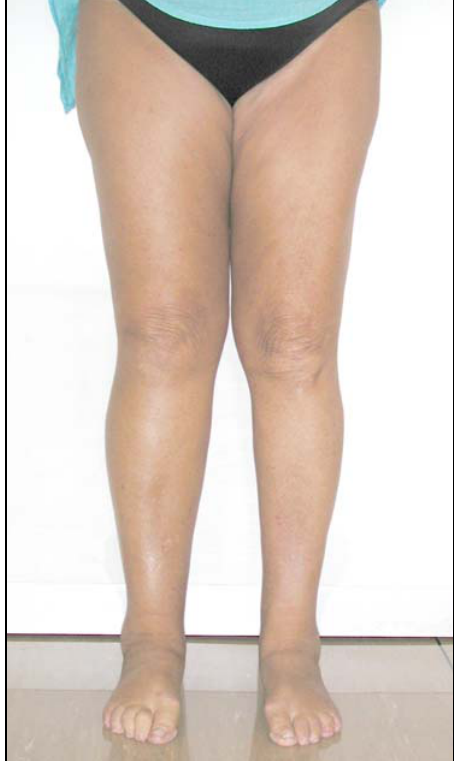
FIGURE 1. Mild unilateral non-pitting edema of the entire right